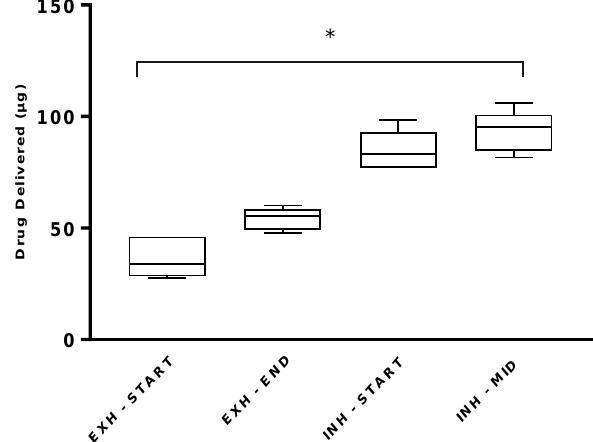
Figure 3. Drug delivery from pMDI actuation at different stages of the respiratory cycle (INH = inhalation; EXH = exhalation) during simulated mechanical ventilation with active humidification. Testing was completed with the pMDI and the MiniSpacer. Results are presented as mean ± SD µg drug delivered. * Denotes statistical significance at p < 0.0001.